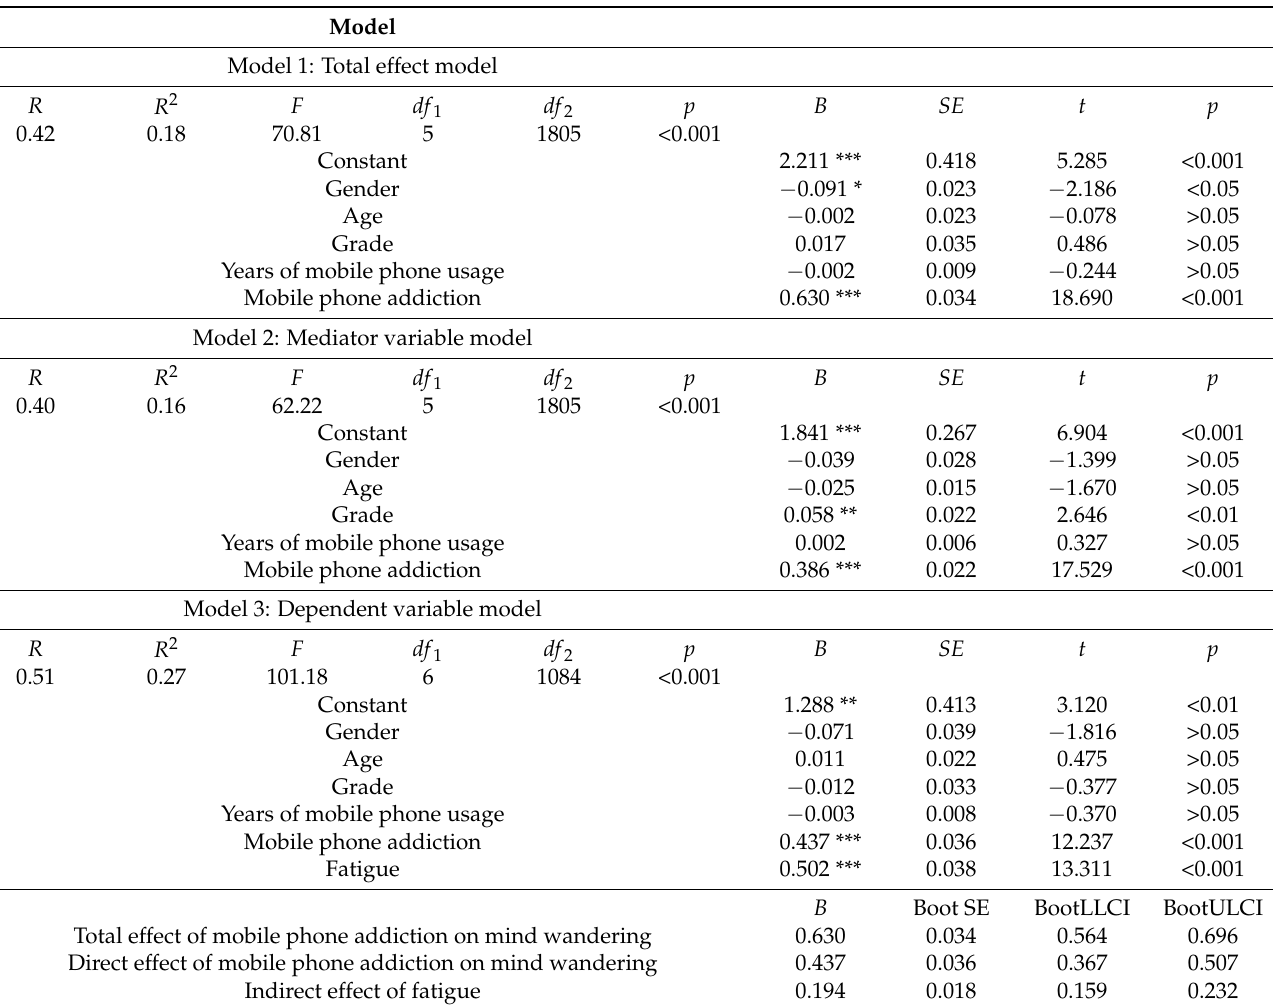
Table 2. Regression results for the mediating effect of fatigue (mediation